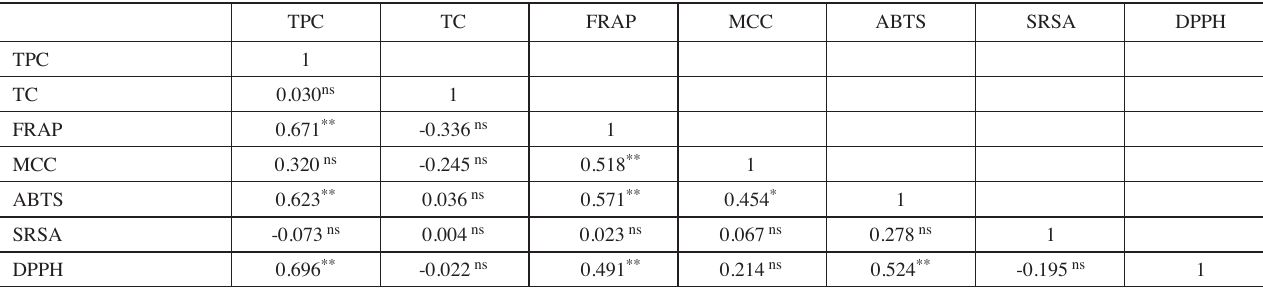
Note: TC: Total carotenoids; TPC: Total phenolics; ns: Non-significant; *: level of significance (* p < 0.05, ** p < 0.001).